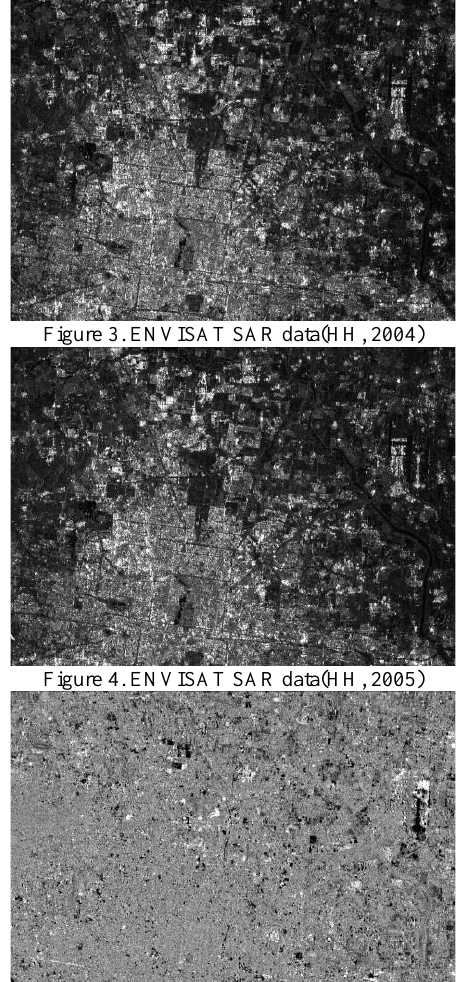
Figure 5. Difference map after PCA